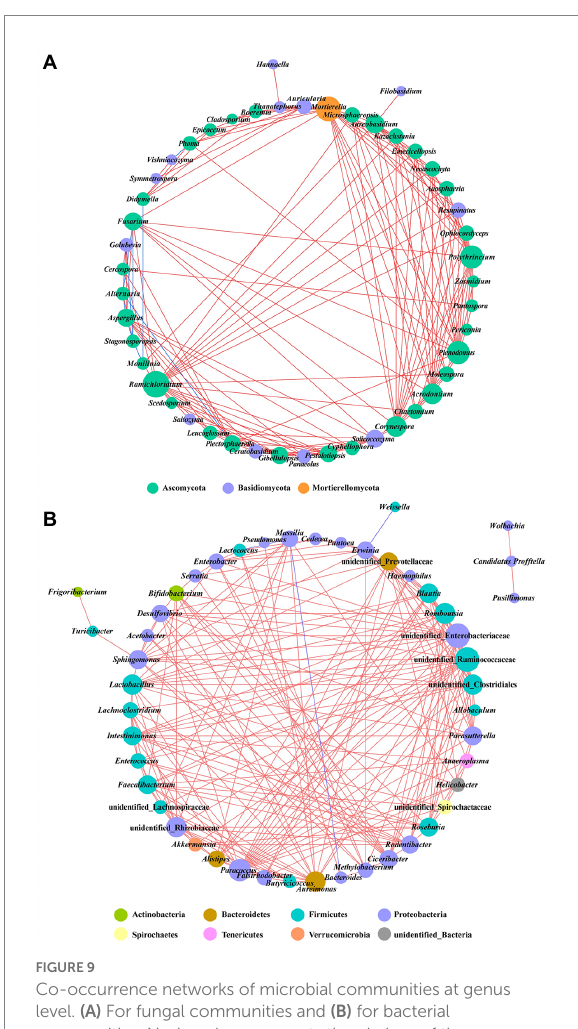
FIGURE 9 Co-occurrence networks of microbial communities at genus level. (A) For fungal communities and (B) for bacterial communities. Node color represents the phylum of the genus and the size corresponds to the centrality score. Red lines indicate positive relationships, and blue lines indicate negative